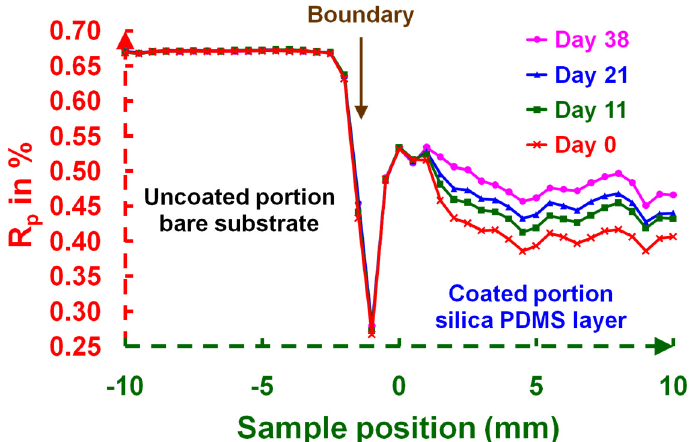
Figure 16. R p coefficient as a function of the direction Y, as indicated by the pink line (X = 0 mm) drawn in Figure 15a.